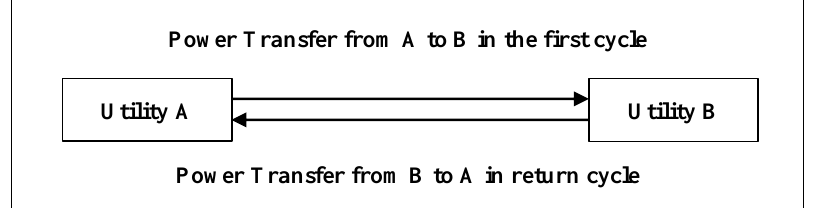
Figure 2. Concept of Energy Banking between two Utilities